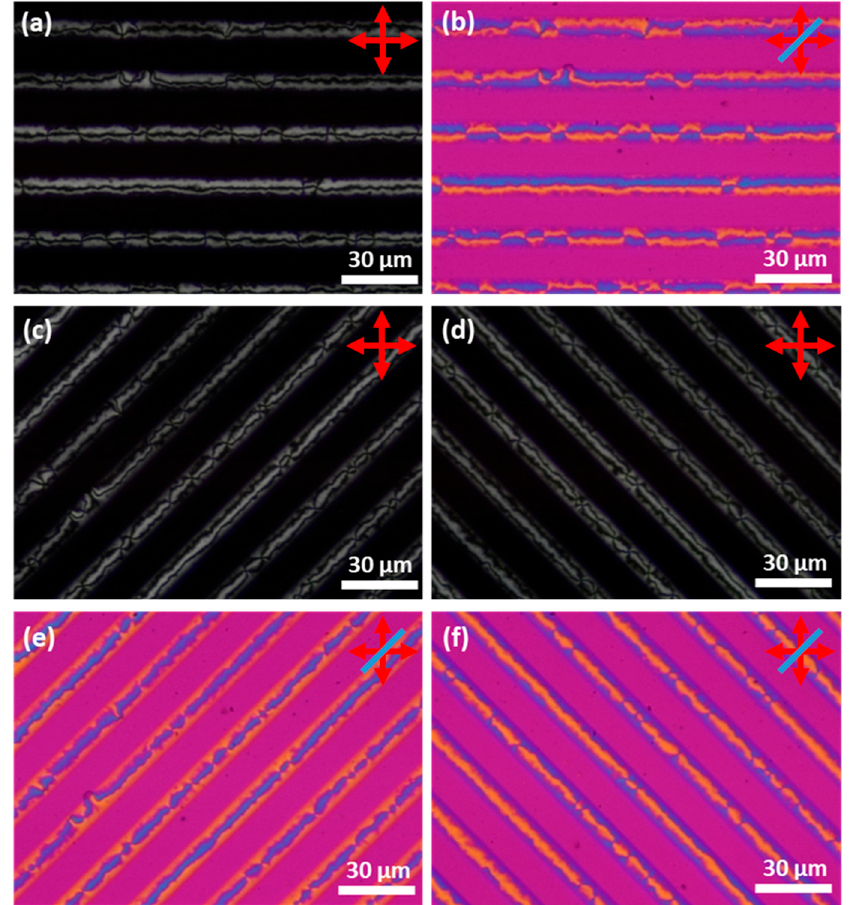
Figure 7. POM images for de ‐ wetted stripes of the E7 exhibiting an escaped radial director field. Both hydrophilic and hydrophobic stripes 10 µ m wide. ( a ) Crossed polarisers with the stripes parallel to one polarisation direction. ( b ) With an added wave plate. ( c , d ) Crossed polarisers with the stripes at +45° and − 45° to the vertical polariser. ( e , f ) With an added wave plate. The blue line indicates the orientation of the slow axis of the compensator.